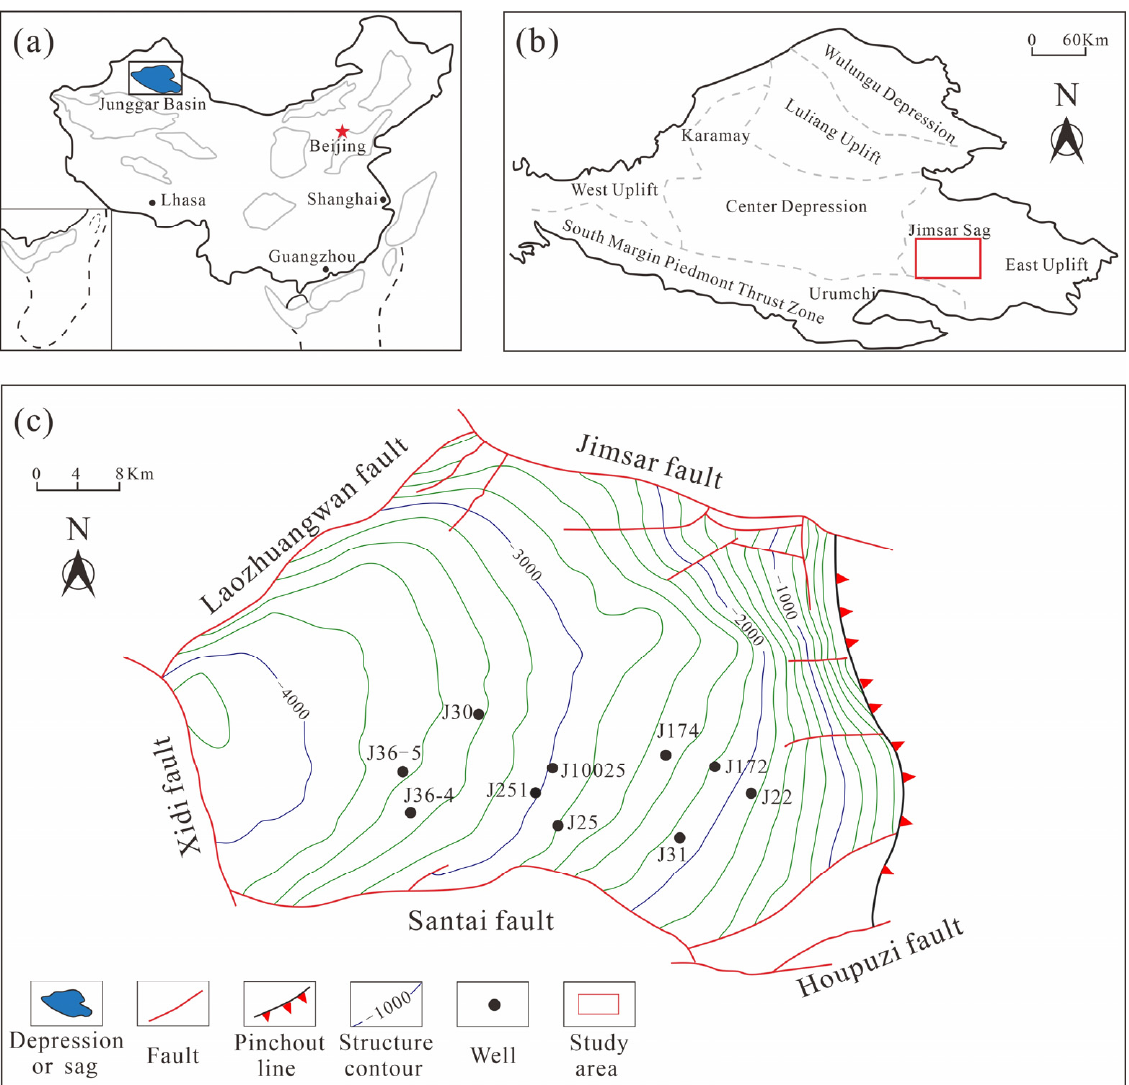
Figure 1. ( a ) Location map of the Junggar Basin in China, ( b ) location map of the Jimsar Sag in the Junggar Basin, and ( c ) regional structural map of Lucaogou Formation in the Jimsar Sag [40,41].